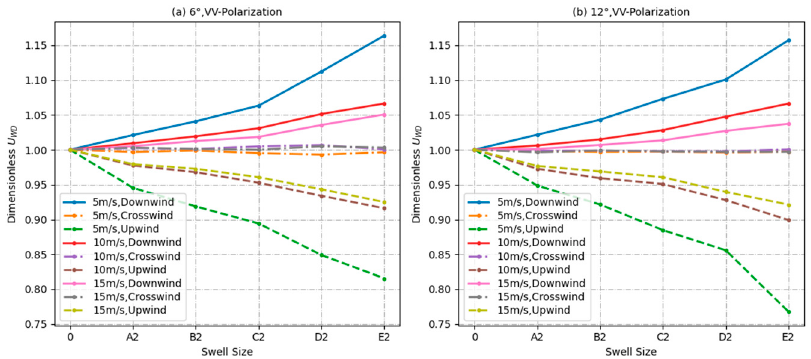
Figure 20. Variation in dimensionless Doppler shift with swell scale for wind speeds of 5, 10, and 15 m/s and radar azimuth of 0°.